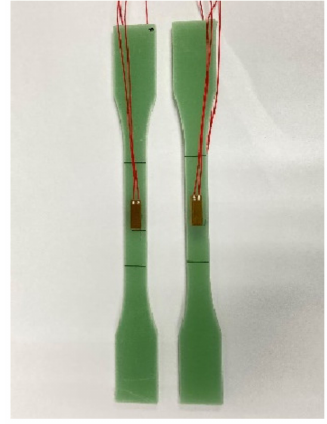
Figure 3. Specimens.